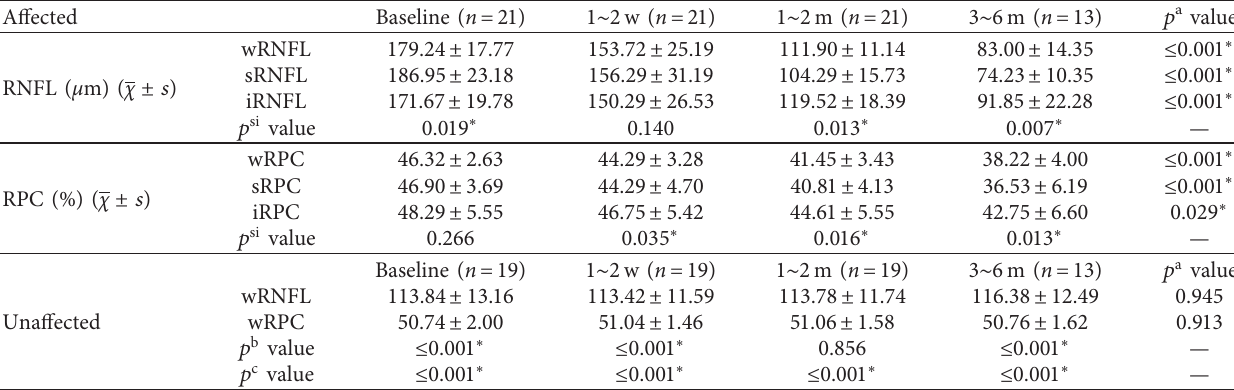
Table 1: OCT and OCT-A parameters in ONH in affected eyes of